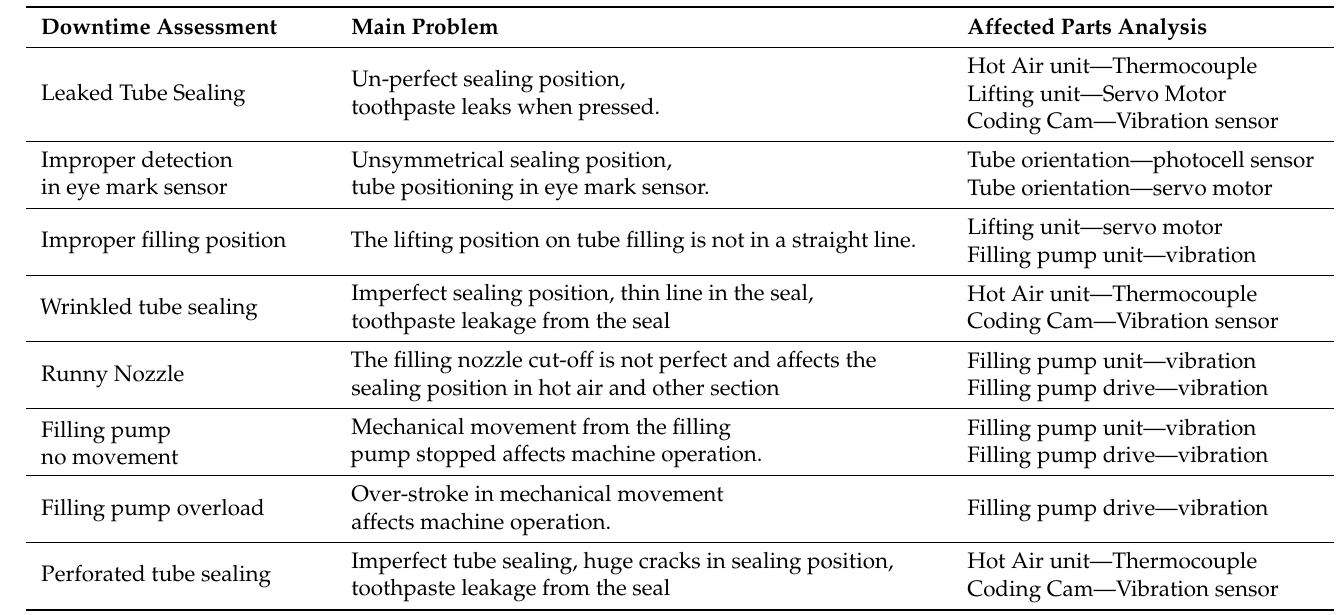
Table 2. Downtime analysis and affected parts classification [20].